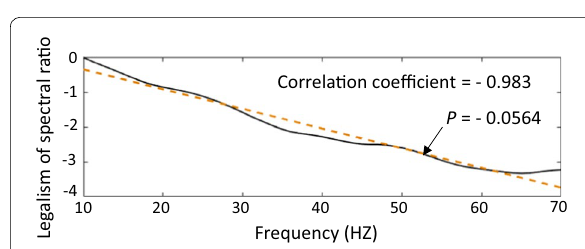
Fig. 4 An example of gradient p computation and correlation coefficient on linear approximation. Black solid curve shows the logarithm of spectral ratio function of frequency (10–70 HZ) in a time window 8.960–9.088 s at a location of CDP24000. Orange broken line is approximate straight line with gradient p , which was computed by linear approximation with the least squares method. The correlation coefficient on the approximation was −